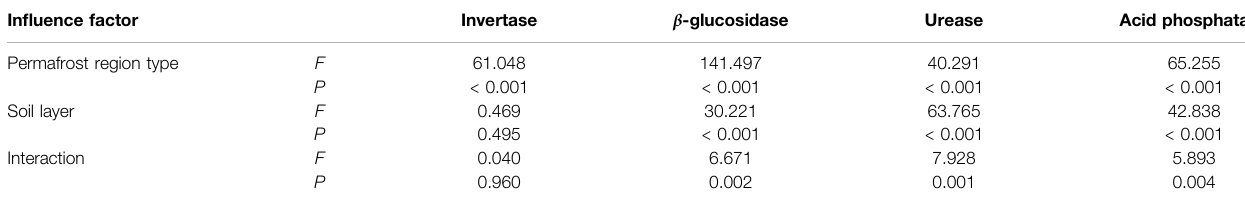
TABLE 3 | Two-way ANOVA on the effects of permafrost region type, soil layer and their interaction effects on soil invertase, β -glucosidase, urease, and acid phosphatase activity.